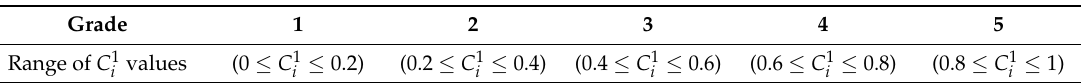
Table 6. Division of C 1